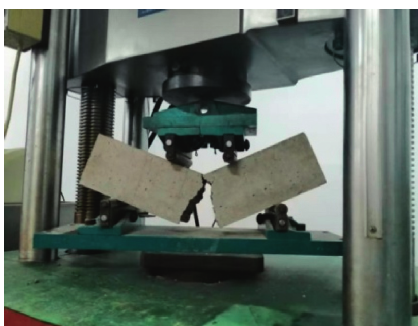
Figure 2: Flexural test of concrete.